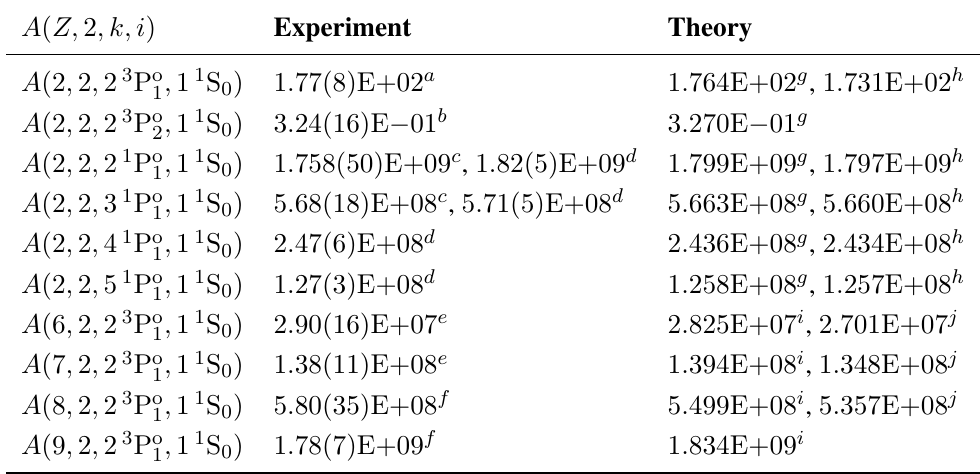
Table 8. Experimental and theoretical transition rates (s − 1 ) for He-like ions. a [151]; b [152]; in brackets gives the experimental